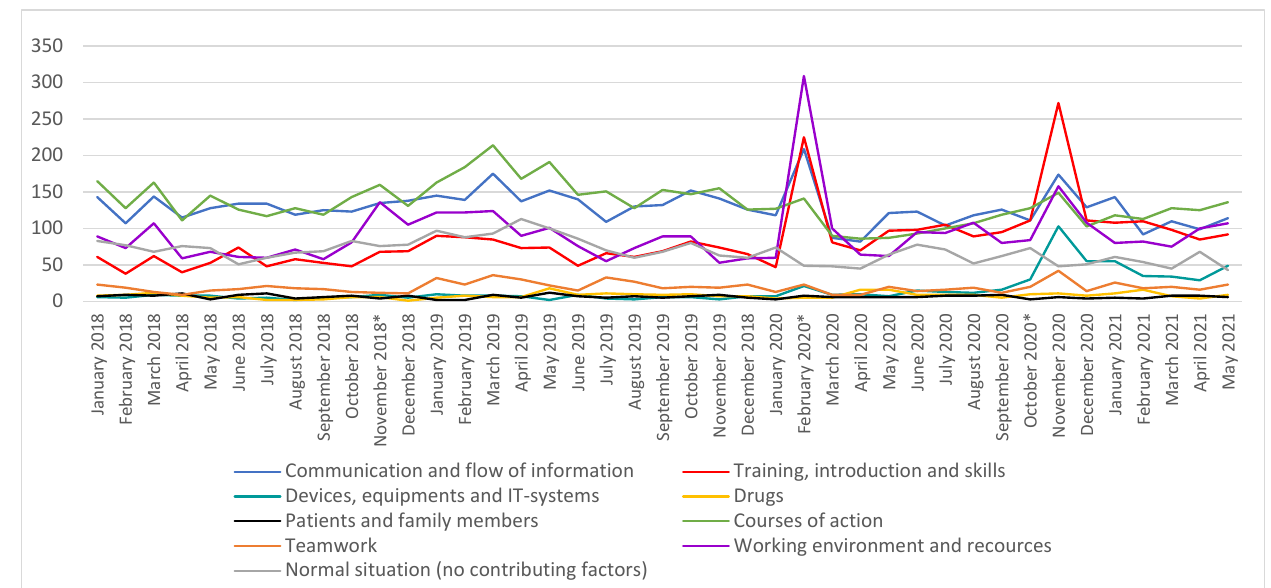
Figure 3. Trends in the reporter contributing factors related to MEs during 1/2018 – 5/2021. * Different implantation phases (Go-lives = GLs) GL1: 11/2018, GL 2.1: 2/2020 and GL 2.2. 10/2020. Contributing factors that were not included in the figure include organisation and management (only 0 – 5 reports per month) and not known contributing factors.